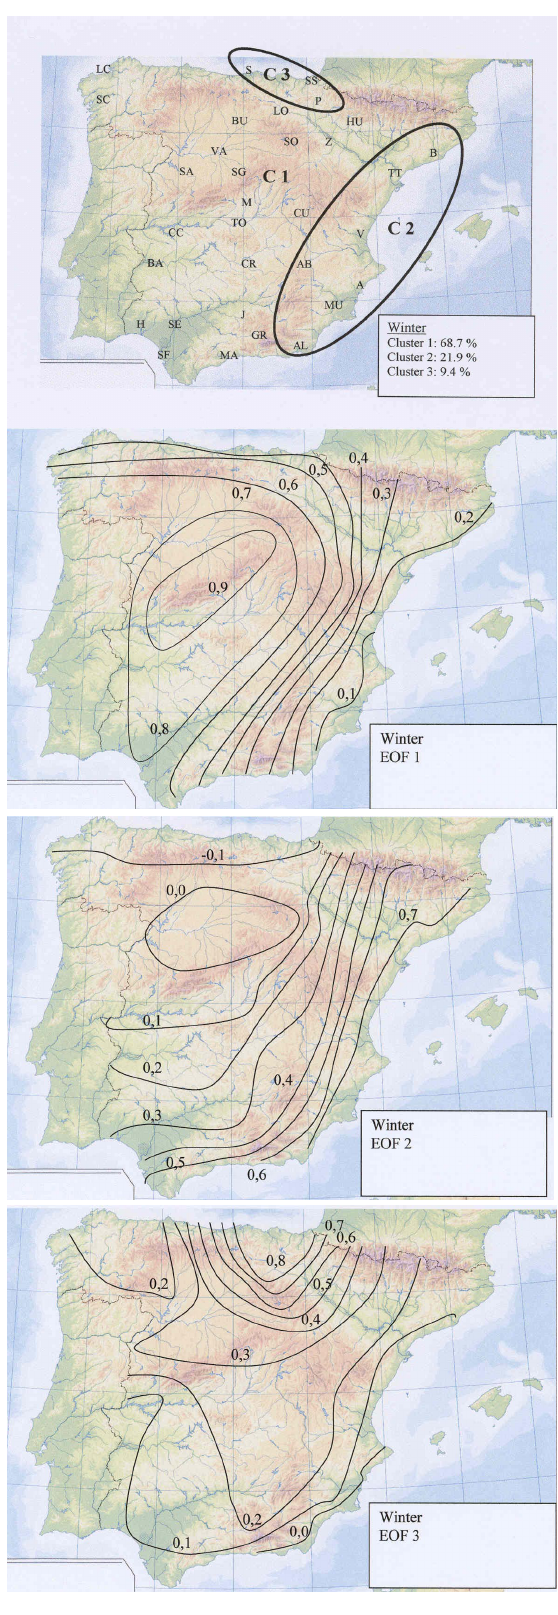
Fig. 6. Regionalization determined by cluster analysis (top panel) and loading factors for the three first rotated EOFs, for winter. In top panel percentage of observations corresponding to each cluster are